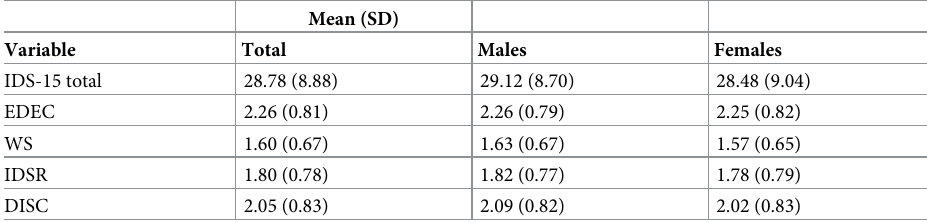
Table 1. Descriptive statistics of IDS-15 score and its